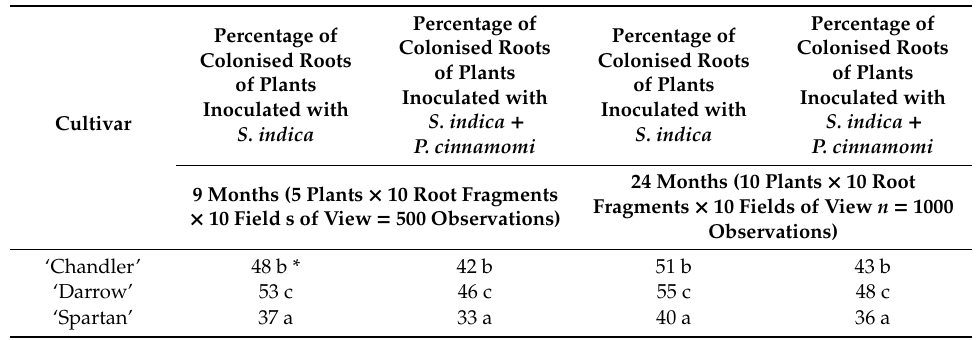
Table 1. Colonisation frequency of roots of highbush blueberry (presence of chlamydospores) with S. indica after 9 and 24 months.